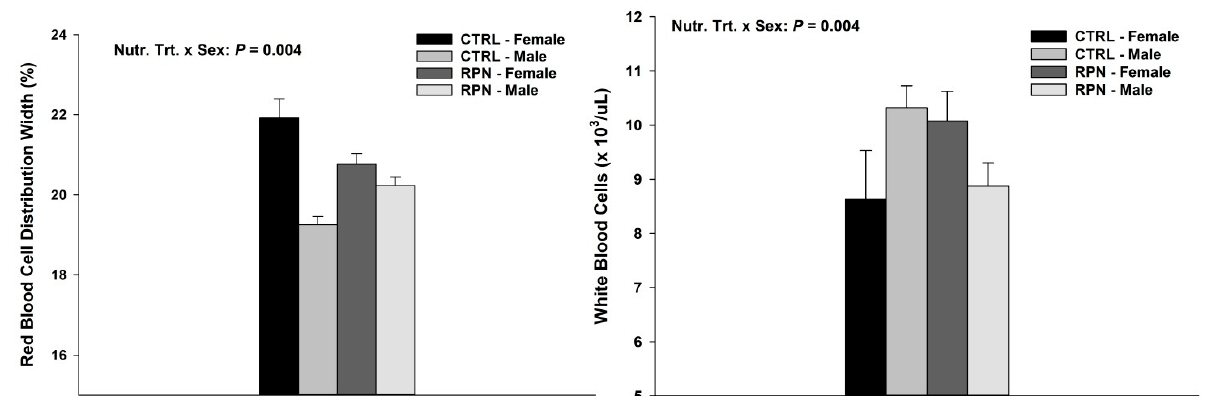
Figure 2. Significant nutritional treatment and sex interactions for hematocrit, hemoglobin, red blood cell distribution width, and white blood cells of Angus × Simmental steers and heifers’ offspring. Hematocrit is represented by the percentage of packed red cells in the blood, hemoglobin (g/dL), red blood cell distribution width (RDW, %), and white blood cells